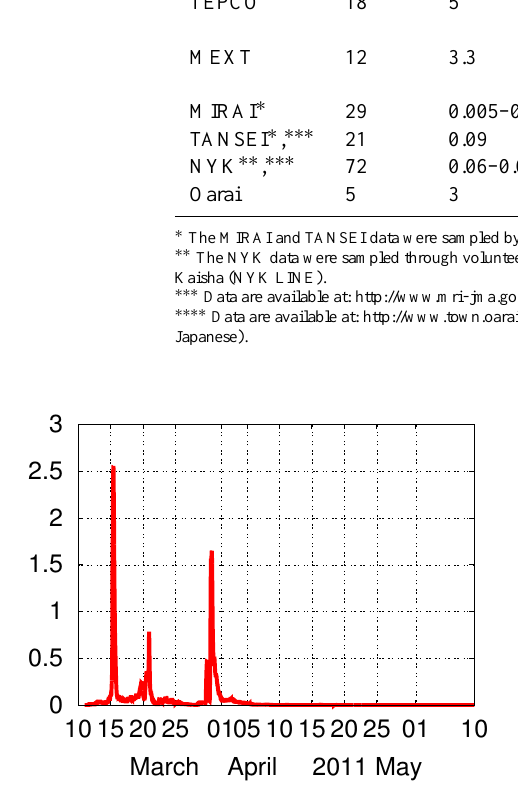
Fig. 2. Time sequences of the simulated atmospheric deposition flux Figure 2 (in GBqs − 1 ) integrated over the western North Pacific, 10.5–62 ◦ N and 108–180 ◦ E.